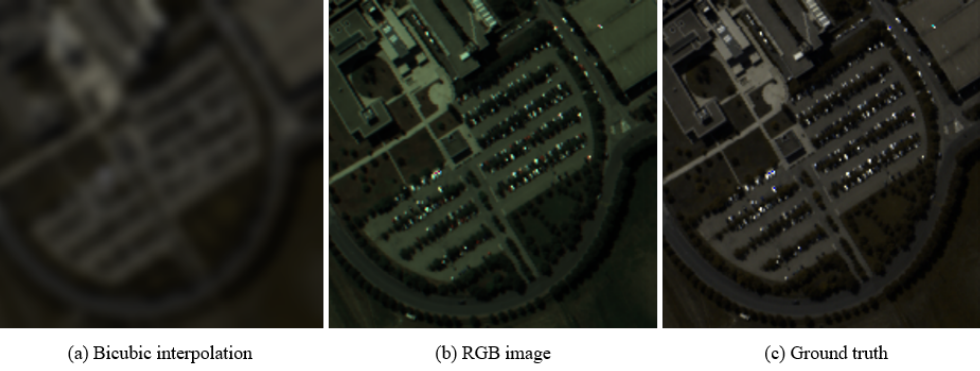
Figure 3. Pavia image, where the color image consists of Spectral Bands 20, 16, and 5 for the red, green, and blue channels, respectively. ( a ) Bicubic interpolation of the observed low-spatial-resolution HSI with a magnification factor of three; ( b ) MSI after applying IKONOS spectral response; only red, green, and blue components displayed; ( c ) the original high-spatial-resolution HSI considered as the ground